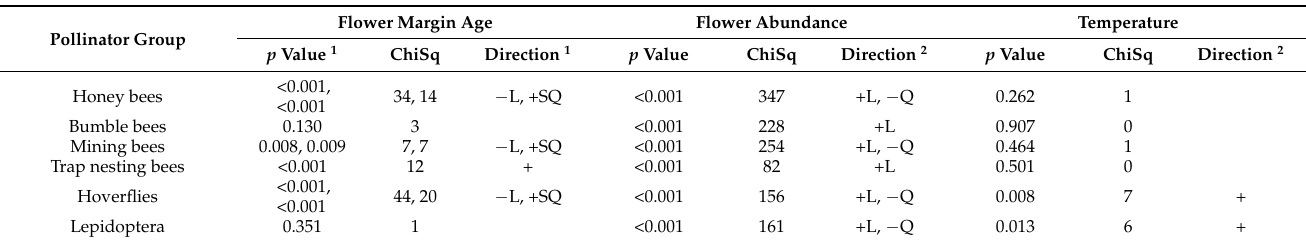
Table 3. The results of the analysis of flower margin age (years since sown with a flower mix to support pollinators) on the abundance of different pollinator groups.